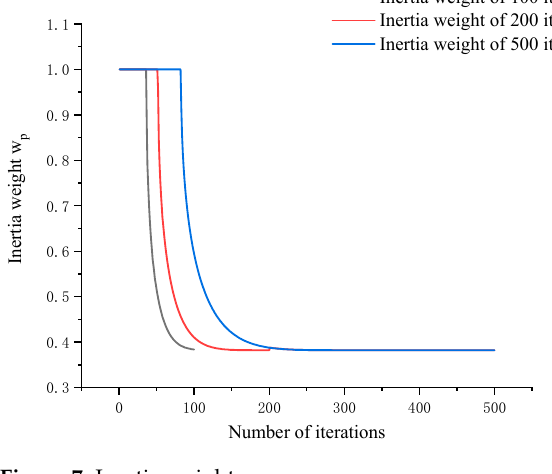
Figure 7. Inertia weight.